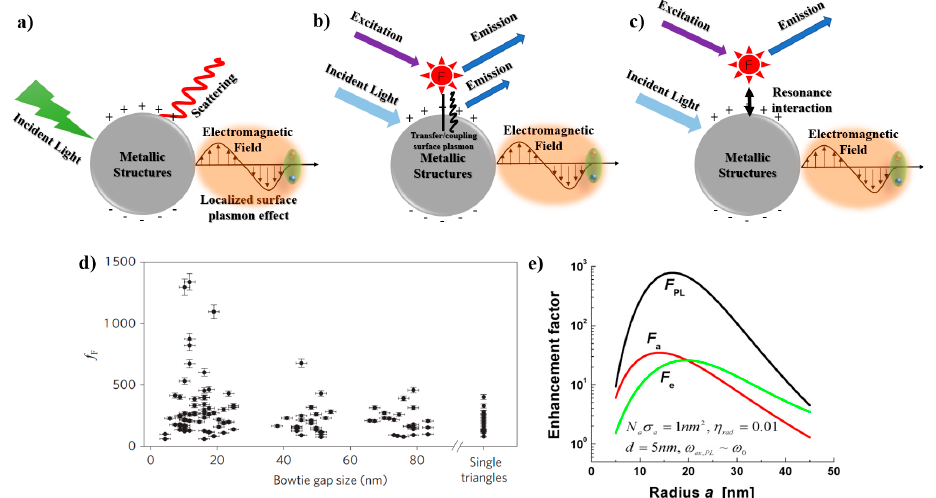
Figure 1. Metal enhanced fluorescence mechanism: ( a ) the localized surface plasmon resonance (LSPR) effect on metallic structures, ( b ) the plasmon coupling effect due to non-radiative interactions, modified from [47], ( c ) the intrinsic radiative decay effect, modified from [47], ( d ) fluorescence enhancement as a function of the bowtie structures gap size (adapted with permission from [50]), and ( e ) fluorescence enhancement (emissions, absorption, and total enhancement) as a function of the structure radius (adapted with permission from [53], Copyright 2009, Optical Society of America).